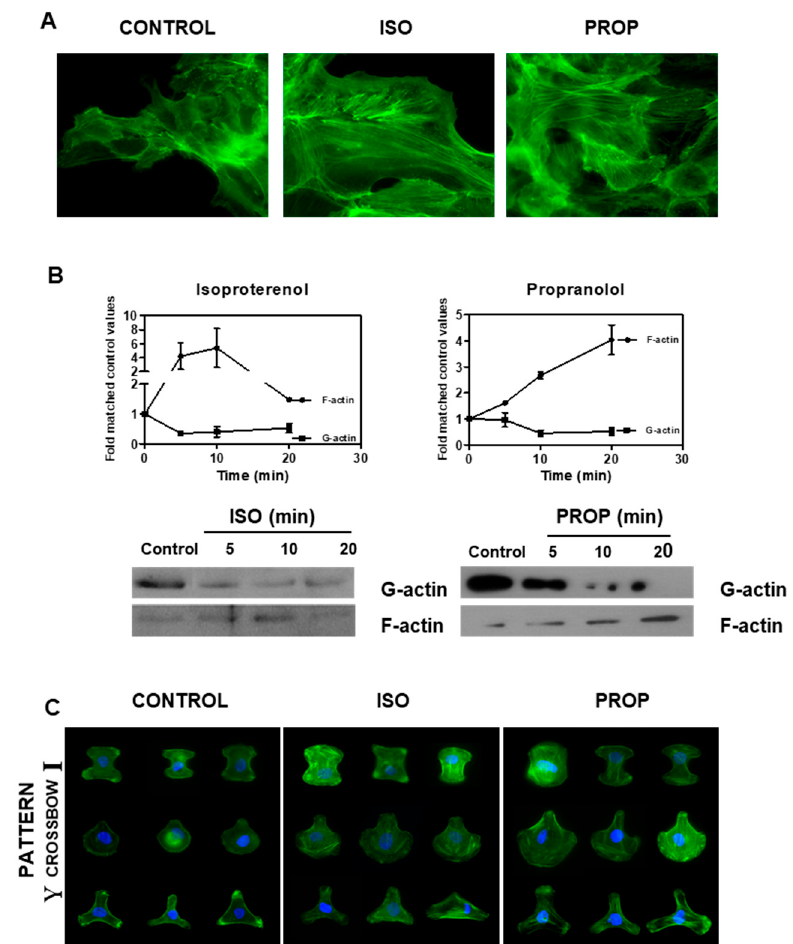
Figure 3. Isoproterenol (ISO) and propranolol (PROP) induce F-actin stabilization on MCF-10A. ( A ) Fluorescence staining with green phalloidin after 10 min of treatment with ISO or PROP. ( B ) Western Blot for F-actin and G-actin after ISO or PROP treatment. ( C ) Actin reorganization on a single cell is shown by adhesion to specific Y, crossbow or I fibronectin micropattern. Data are representative of three independent experiments.